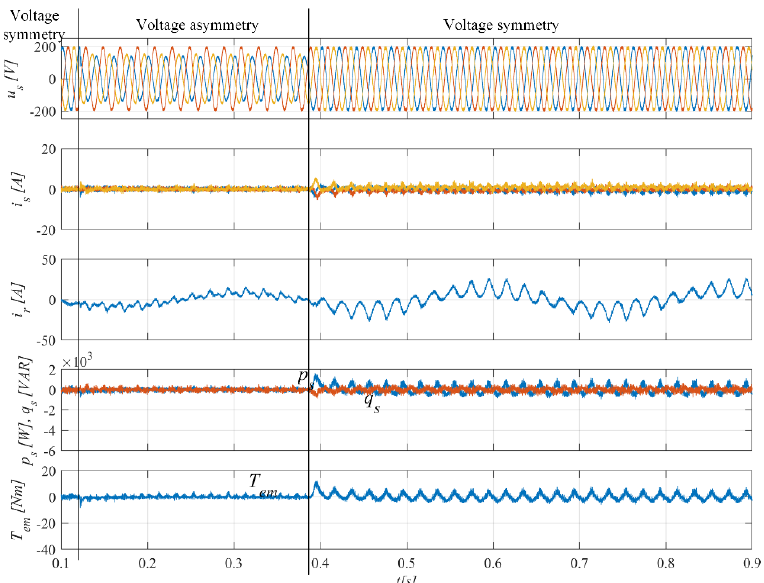
Figure 20. Experimental tests results of DPC showing transient performance in case of asymmetrical grid voltage drop with the feedforward and decoupling mechanism included in the control, Q sref = 0, T emref = 0 Nm.